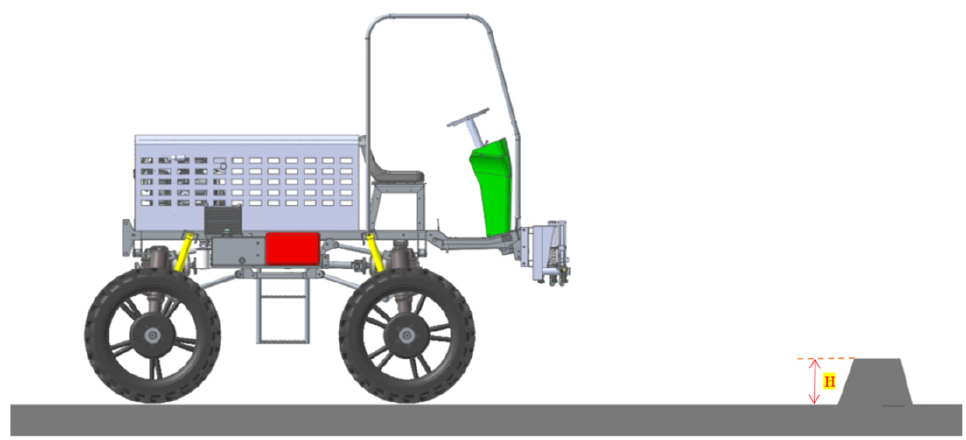
Figure 7. Ridge crossing simulation model of HGPM.